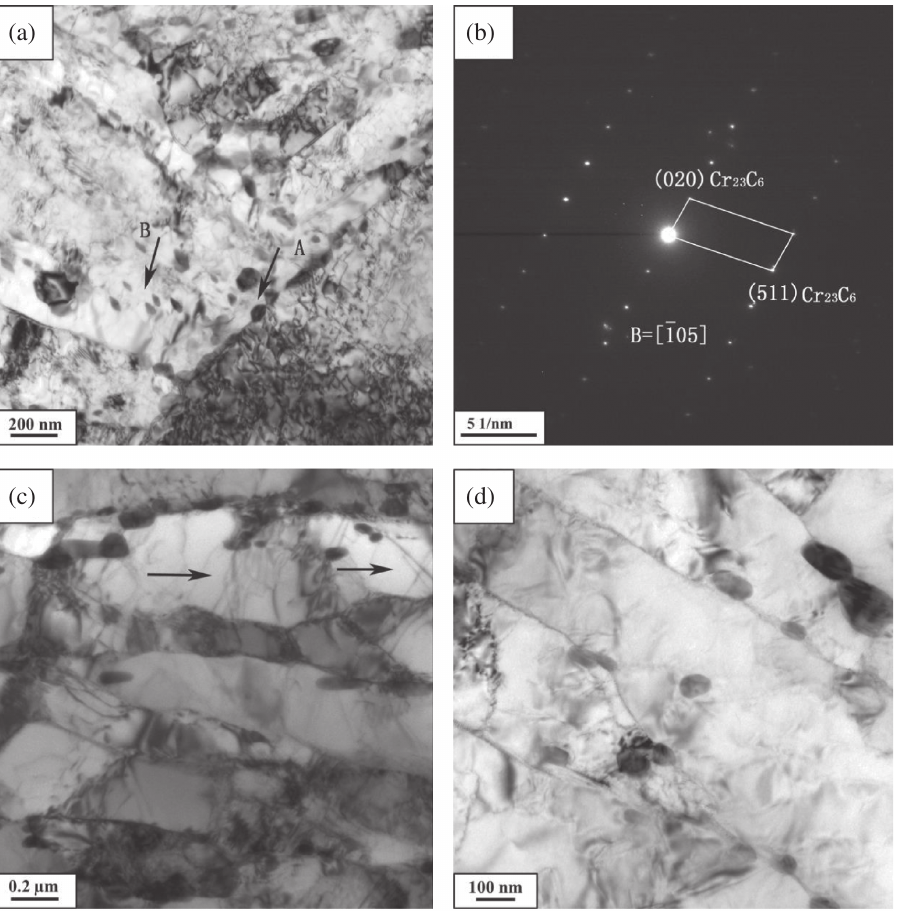
Figure 2: Effect of ageing time at 600°C on TEM microstructures (a) The TEM structure before ageing (b) The SADP in figure (a) A points (c) The dislocation structure before ageing (d) The TEM structure after